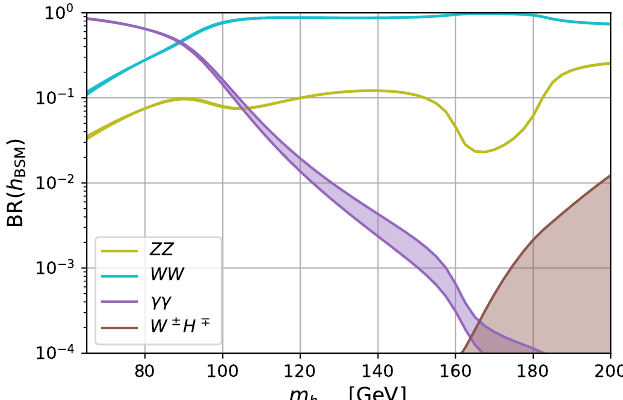
) benchmark scenario as a function of Figure 20. Branching ratios of h BSM in the cH ( Wh fphob BSM . The decays h and h and induce a ± H ∓ additionally depend on m m h BSM → γγ BSM → W H ± BSM small dependence in the remaining BRs through the total width. The bands for each BR indicate the impact of this dependence for 150 GeV < m < 300 GeV H ±